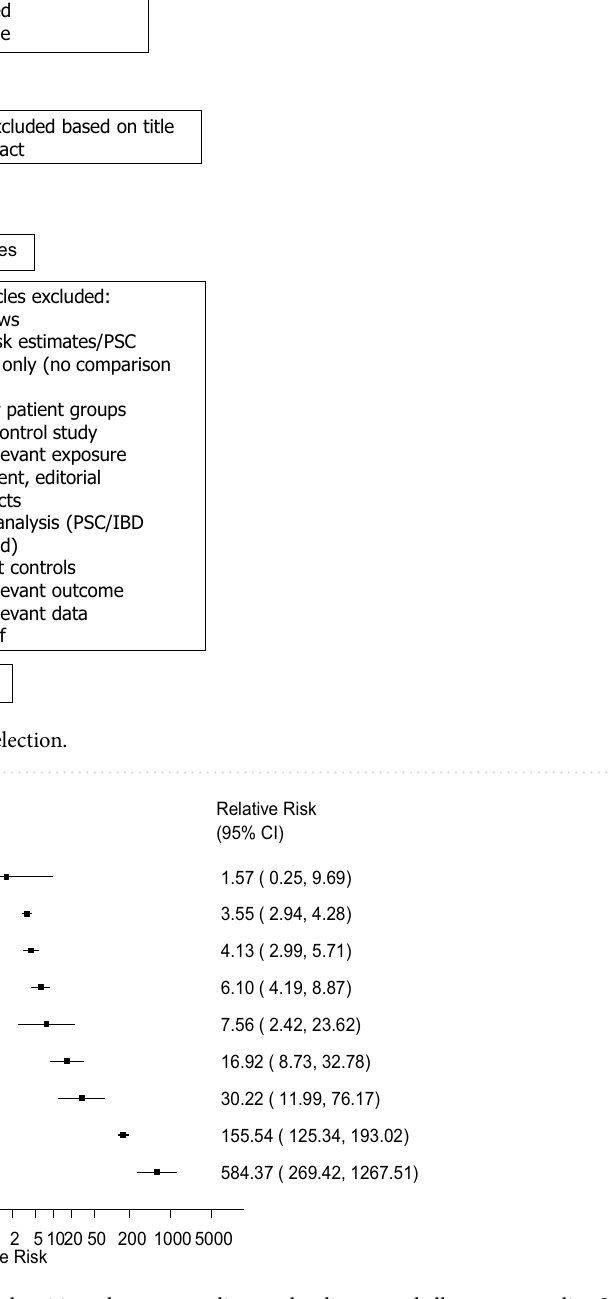
Figure 2. Primary sclerosing cholangitis and cancer, cardiovascular disease and all-cause mortality. Summary relative risks for each outcome are represented by the squares and the 95% confidence intervals are represented by the lines through the squares (n = number of